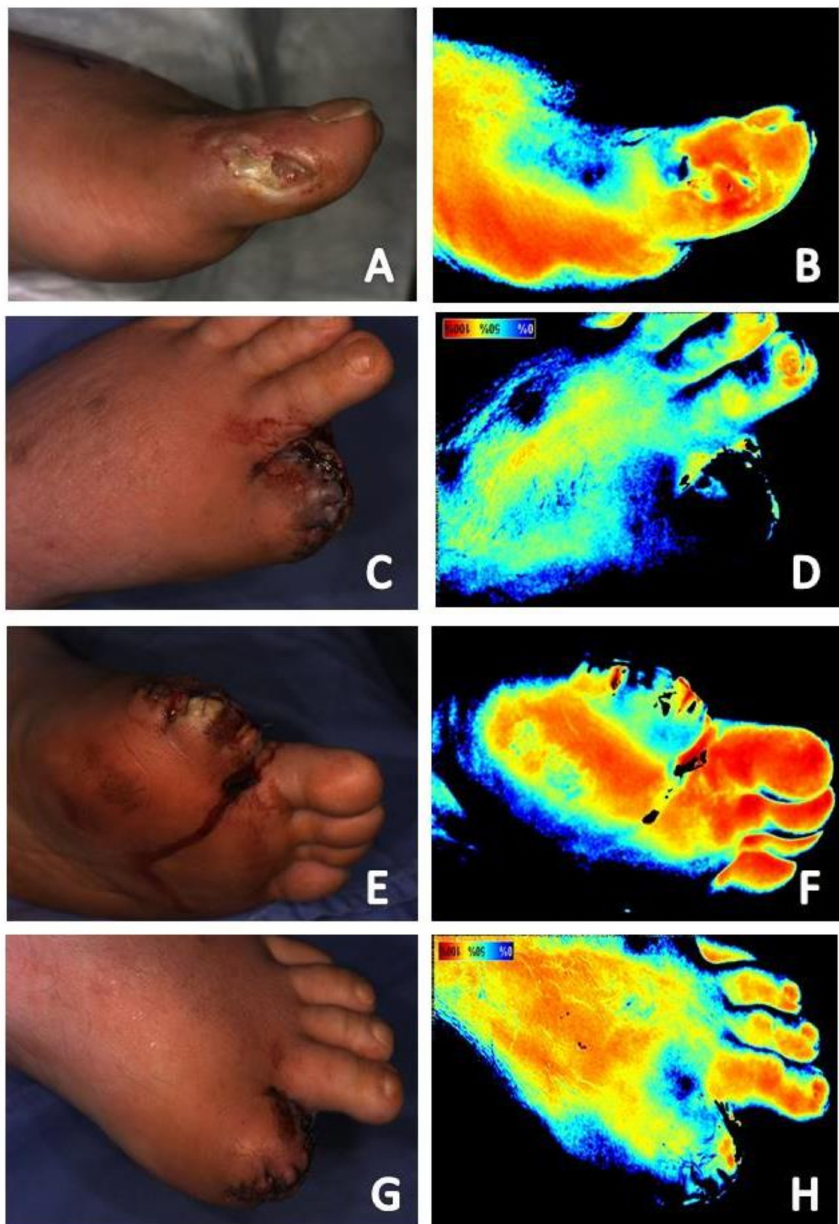
Figure 8. ( A ) Baseline clinical photograph; and ( B ) near-infrared image assessment of a chronic hallux wound complicated by osteomyelitis and local ischemia. Note reduced signal to the dorsal aspect of the hallux and first metatarsophalangeal joint ( B ). Clinical photograph and near-infrared image assessment of the dorsal ( C , D ) and plantar foot ( D , E ) two days following amputation, prior to the patient’s first hyperbaric oxygen therapy session. Note dorsal tissue necrosis ( C ) and reduced signal intensity ( D ) of the dorsal hallux. Necrosis of the plantar skin ( E ) was not as severe as that of the dorsal skin ( C ) following amputation. The plantar hallux had oxygenation tissue, although signal was reduced ( F ). Reduced necrosis ( G ) and increased tissue oxygenation saturation levels ( H ) were noted to the dorsal skin after ten sessions of hyperbaric oxygen